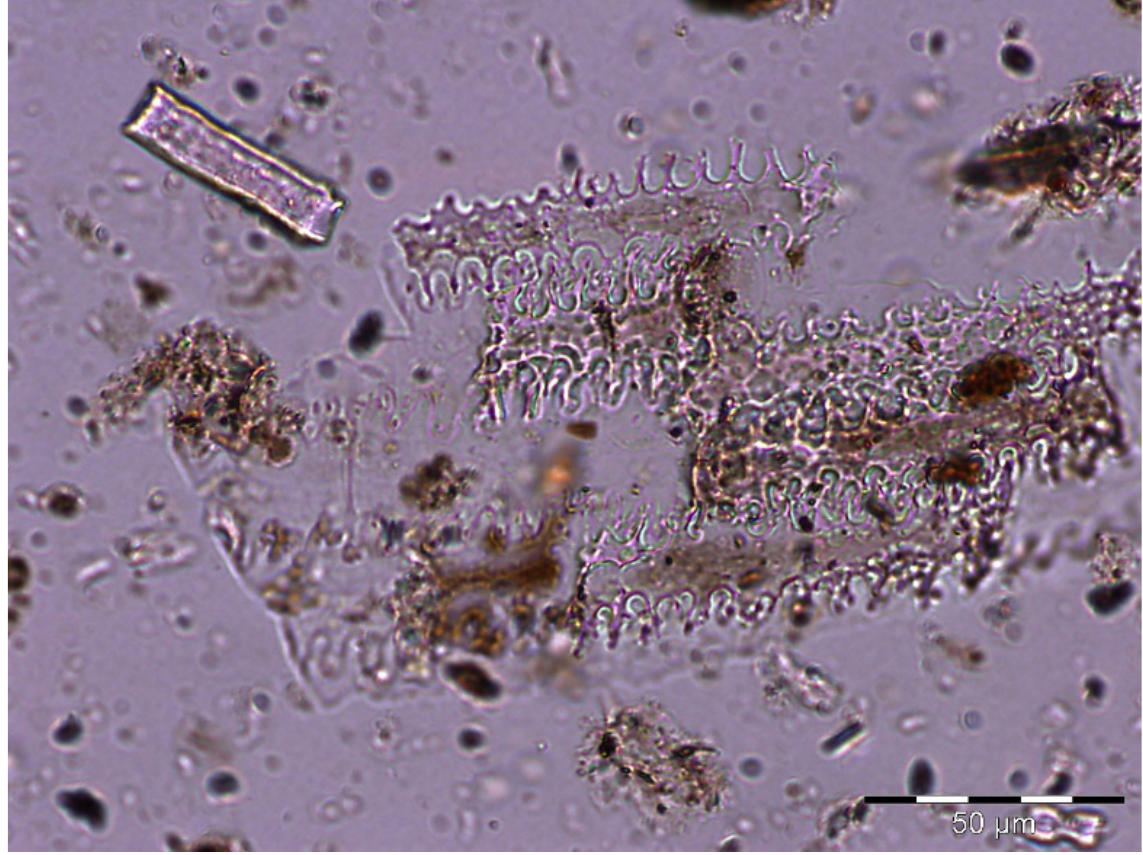
Figure 2. Phytoliths from sample